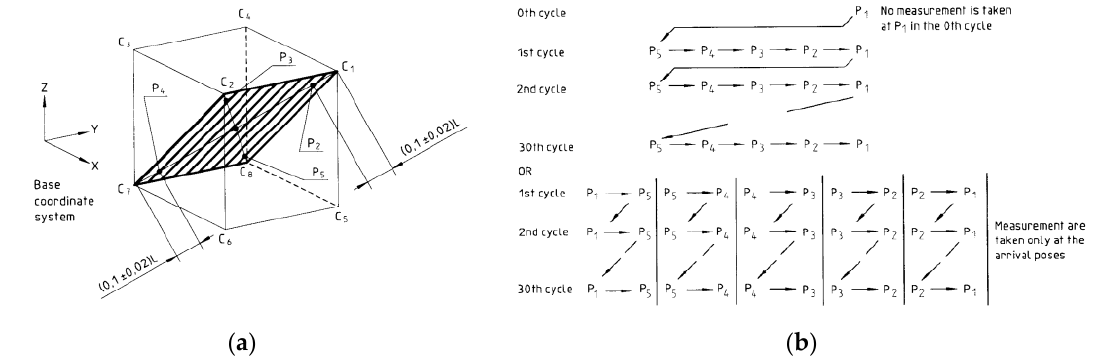
Figure 16. ( a ) Position plan for test no. 3; ( b ) Sequence of movement.